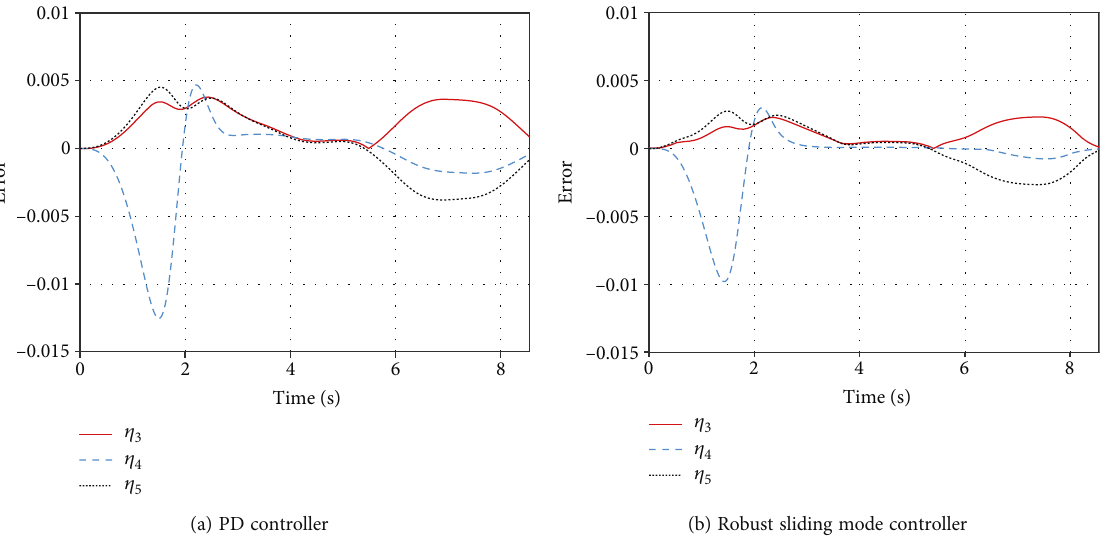
Figure 8: Comparison of tracking error of two control algorithms.